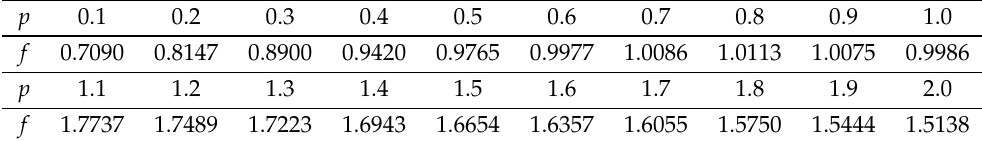
Table 2. Price of the European option with different p (compound Simpson formula).